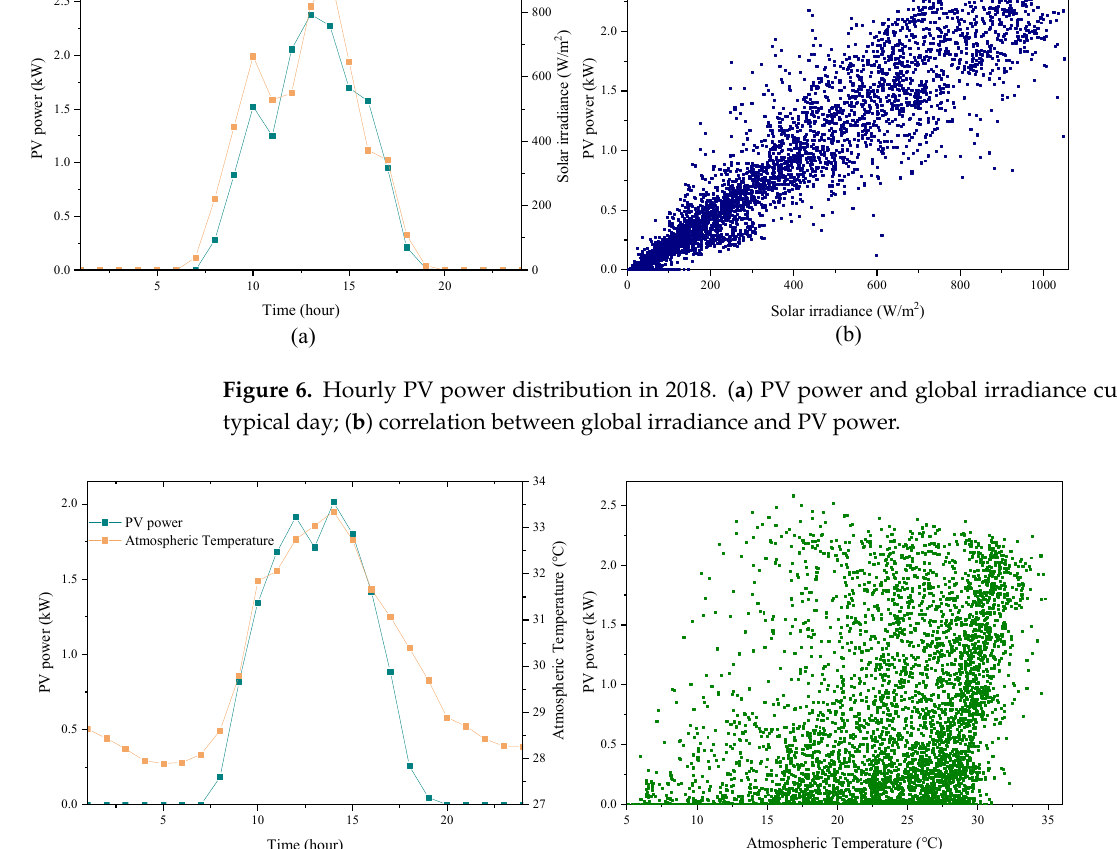
Figure 7. PV power and atmospheric temperature curves. ( a ) PV power and atmospheric tempera- ture curves of a typical day; ( b ) correlation between atmospheric temperature and PV power.